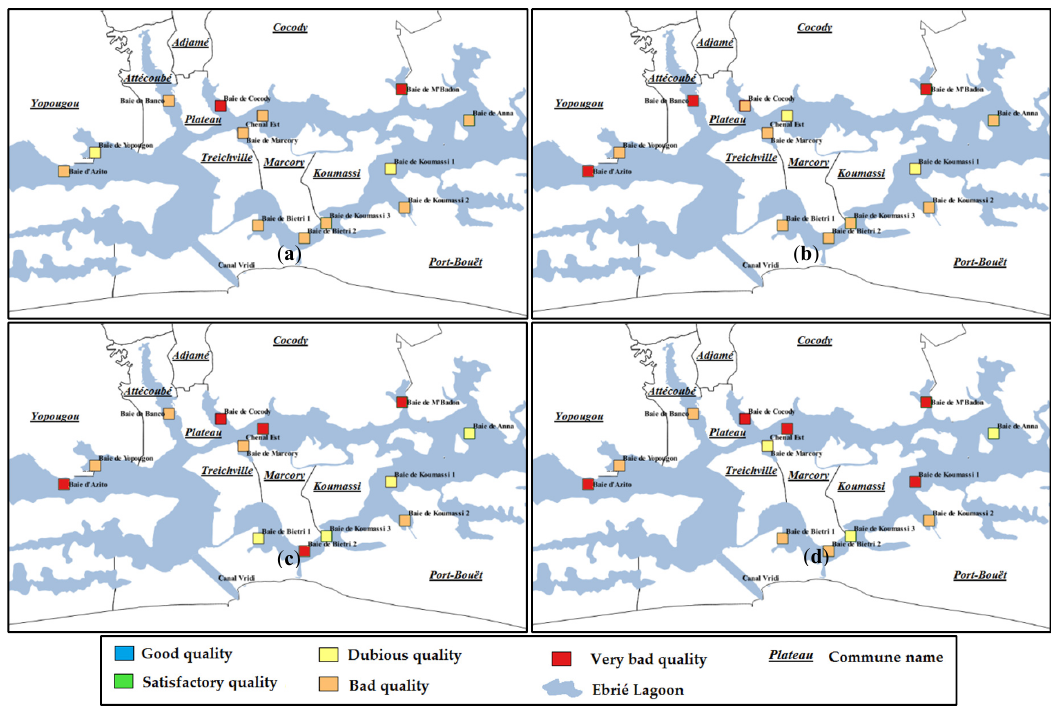
Figure 3. Spatio ‐ temporal variation of the Water Quality Index for aquaculture: ( a ) June 2014, ( b ) June 2015, ( c ) December 2014, and ( d ) December 2015.